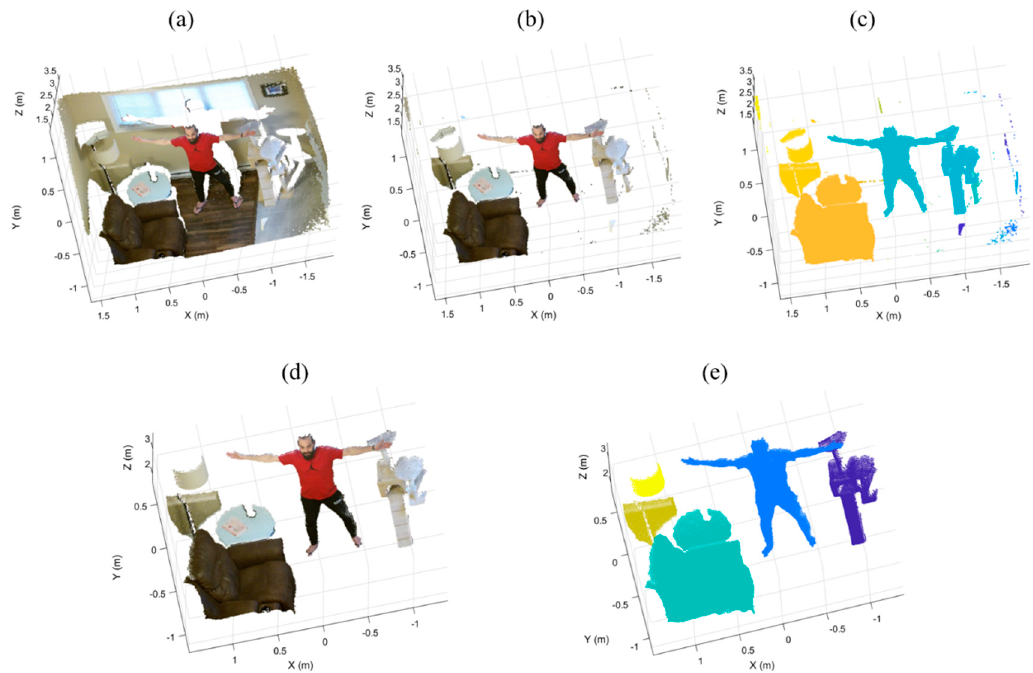
Figure 6. Euclidean clustering on the sample point cloud ( a ) following the iterative plane removal ( b ) results in properly segmented foreground object clusters as well as residual clusters ( c ). Removing object clusters with fewer than µ points leaves only foreground objects ( d ) which can be visualized as colored objects ( e ).